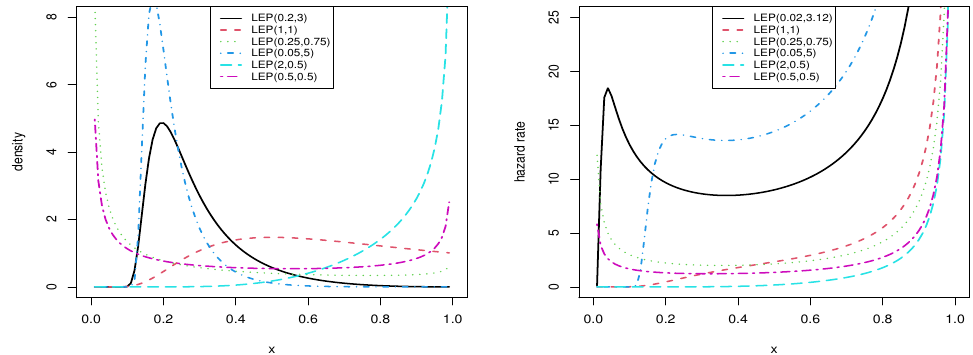
Figure 1. The possible shapes of the pdf ( left ) and hrf ( right